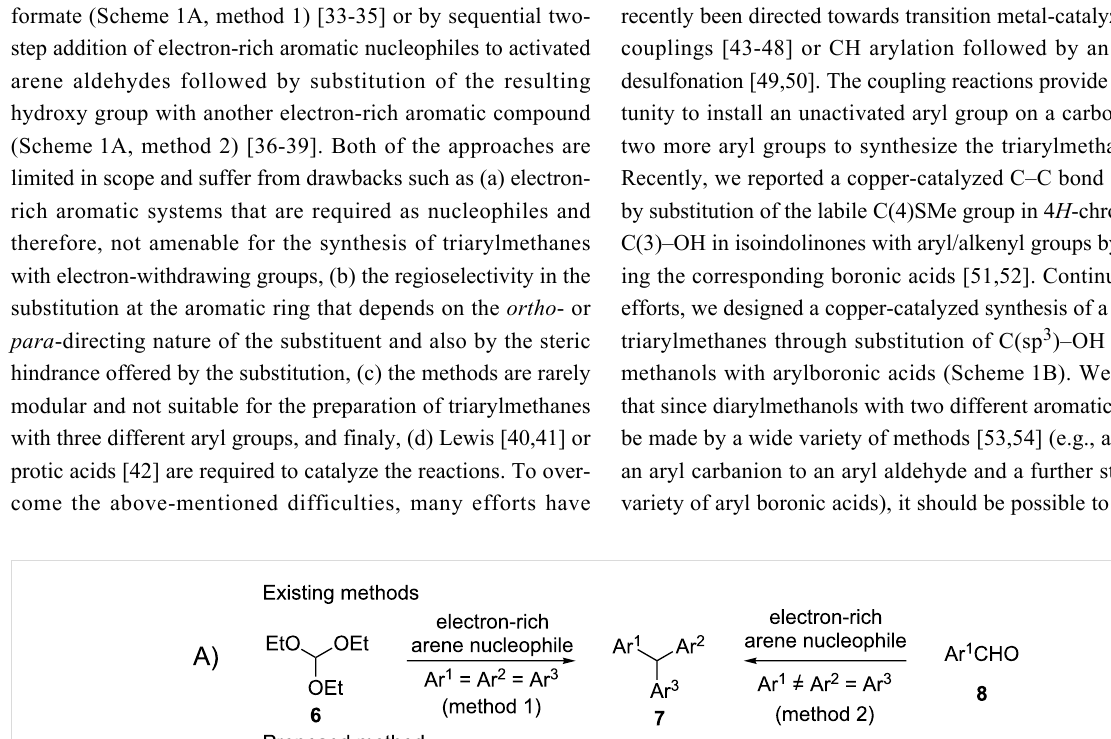
formate (Scheme 1A, method 1) [33-35] or by sequential